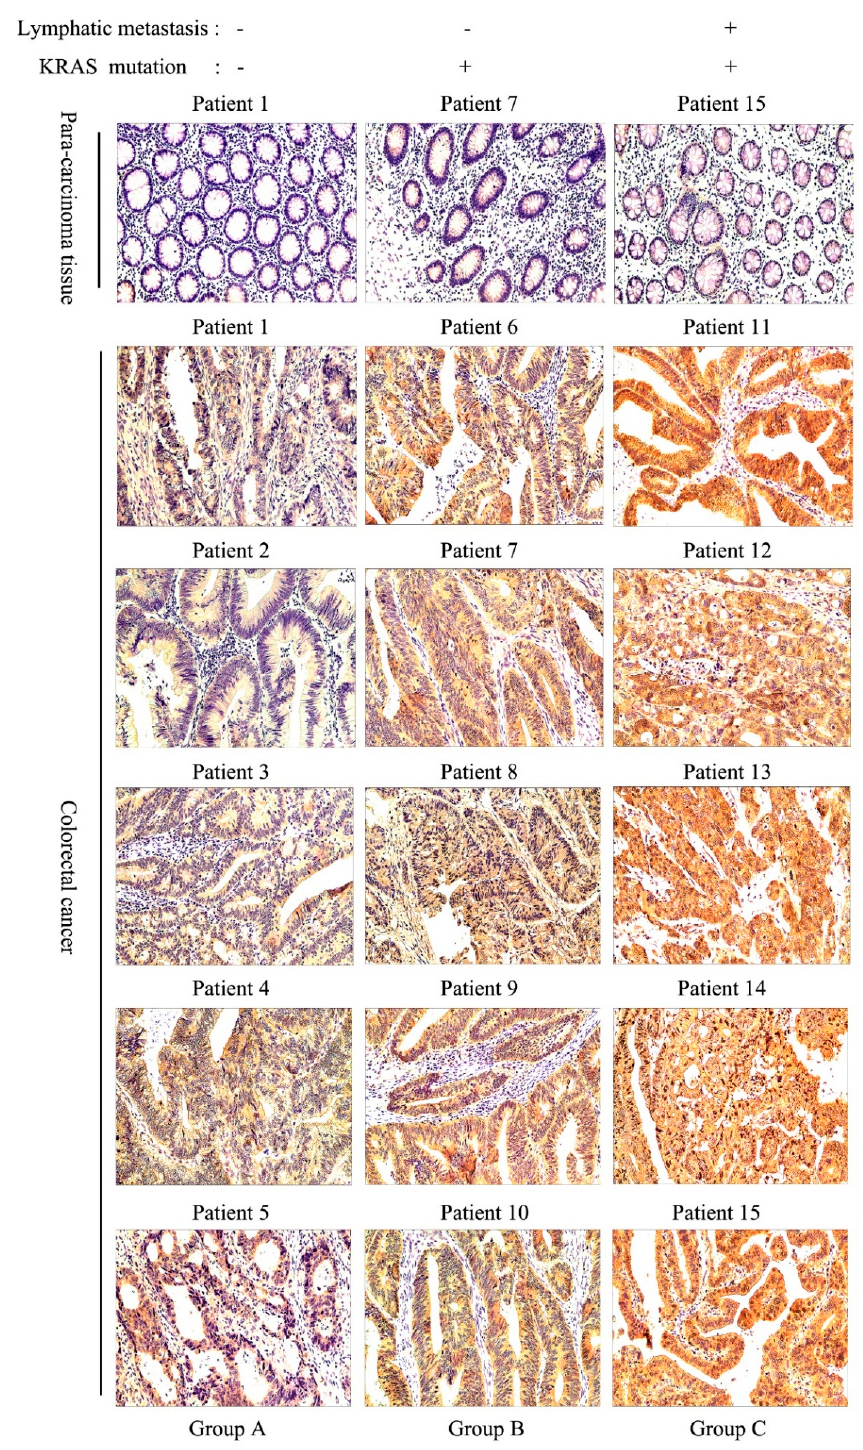
Figure 3. High expression of ACY1 is associated with lymph node metastasis and cetuximab resis- tance in CRC. Representative IHC images of the expression of ACY1 in tissue samples from CRC patients. Patient #1~#5: lymph node metastasis negative, KRAS wild type. Patient #6~#10: lymph node metastasis positive, KRAS wild type. Patient #11~#15: lymph node metastasis positive, KRAS mutant type. KRAS mutation indicates cetuximab resistance in